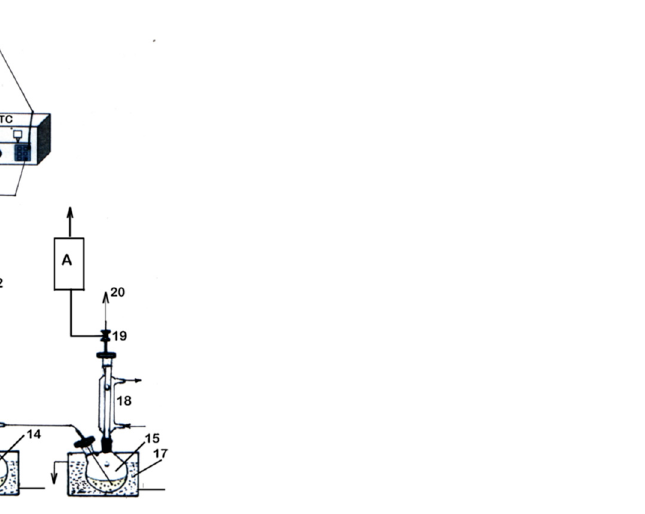
Figure 2. Scheme of experimental setup for biomass pyrolysis. (1)—N 2 tank; (2)—pressure controller; (3)—adjusting valve; (4)—flowmeter; (5)—reactor; (6)—electrical furnace; (T)—temperature control; (7) and (8)—metallic sieve; (9) and (10)—metallic perforated support; (11)—biomass bed; (12)—catalyst bed; (13)—ceramic filter; (14) and (15)—liquid product collector; (16)—cooling bath (85 °C); (17)—cooling bath (10 °C); (18)—condenser with water (5 °C); (19)—two-way valve; (20)—gas product. (A)—analyzer.